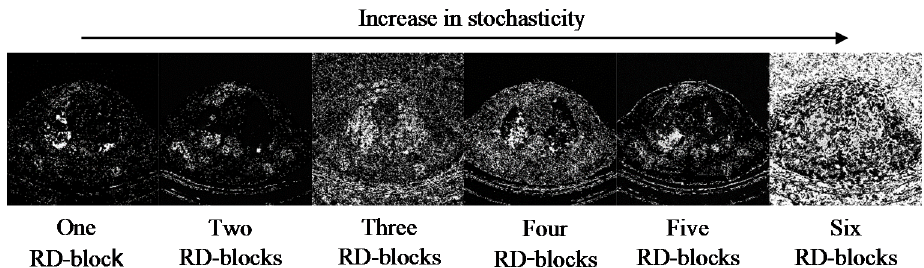
Figure 6. Image difference between a reference output and a second output generated for different numbers of RD-blocks in training mode. The six RD-blocks variation shows the largest magnitude of image difference.